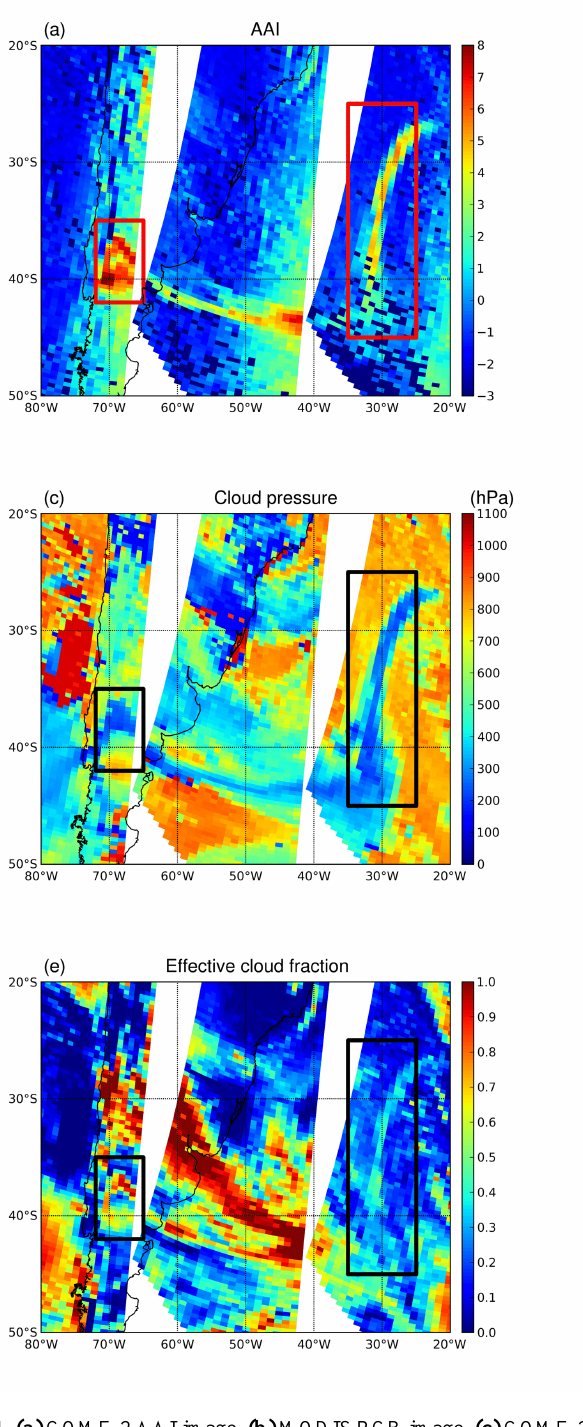
Fig. 11. (a) GOME-2 AAI image, (b) MODIS RGB image, (c) GOME-2 cloud pressure, (d) GOME-2 scene pressure, (e) GOME-2 effective cloud fraction, and (f) GOME-2 scene albedo for the Puyehue volcanic ash plume on 6 June 2011. The location of the plume is indicated with a box in the GOME-2 images. The plumes in the left and right boxes were measured around 14:10 and 10:45UTC, respectively. The MODIS image was measured at